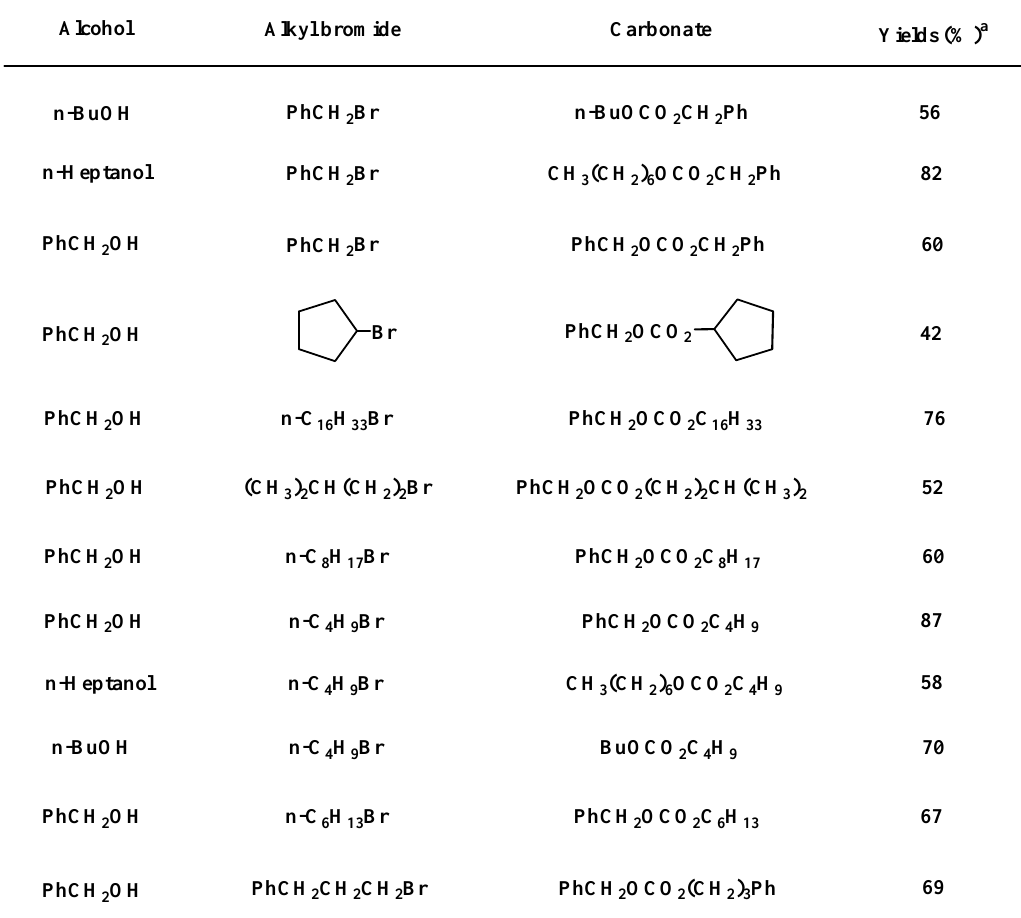
Table 2. Reactions of alcohols with different alkyl bromides under CO 2